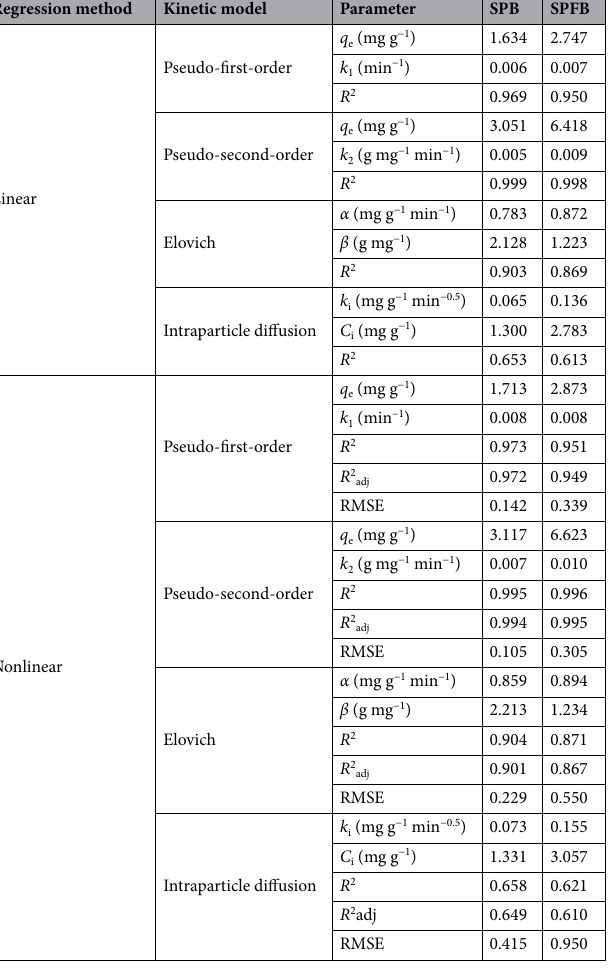
Table 8. The comparison of linear and nonlinear kinetic parameters for RB4 dye adsorptions on sawdust beads (SPB) and sawdust powder doped iron (III) oxide-hydroxide beads